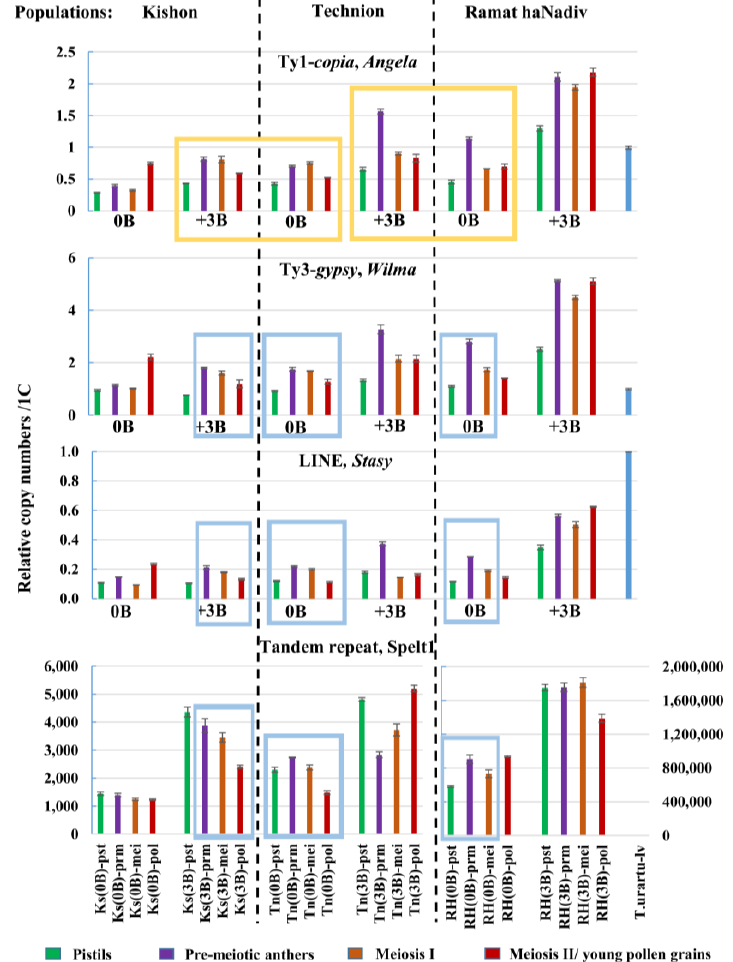
Figure 4. Relative copy numbers of the Angela, Wilma , and Stasy TEs and the Spelt1 TR per haploid genome in somatic and generative tissues of the spike in individual genotypes of Ae. speltoides . The genotypes (0B) and (3B), which are similar in the copy number dynamics for Angela , Wilma and Stasy , are indicated by yellow boxes. The genotypes Ks(0B) and RH(3B) differ in their TE contents, but they have similar copy number dynamics for Angela , Wilma , and Stasy . Spike tissues of the genotypes, which have similar copy number dynamics of Spelt1 and the three TEs, are indicated by blue boxes. The relative copy numbers are indicated along the vertical coordinate axis. Abbreviations for the genotypes are indicated along the horizontal axis. Genotypes from the Kishon population: Ks(0B), genotype without Bs; Ks(3B), genotype with three Bs. Genotypes from the Technion population: Tn(0B), genotype without Bs; Tn(3B), genotype with three Bs. Genotypes from the Ramat haNadiv population: RH(0B), genotype without Bs; RH(3B), genotype with three Bs. Abbreviations: pst, pistils; prm, pre-meiotic anthers; mei, anthers in meiosis I stages; pol, anthers in meiosis II/young free pollen grain stages; lv, leaves (for T. urartu ).